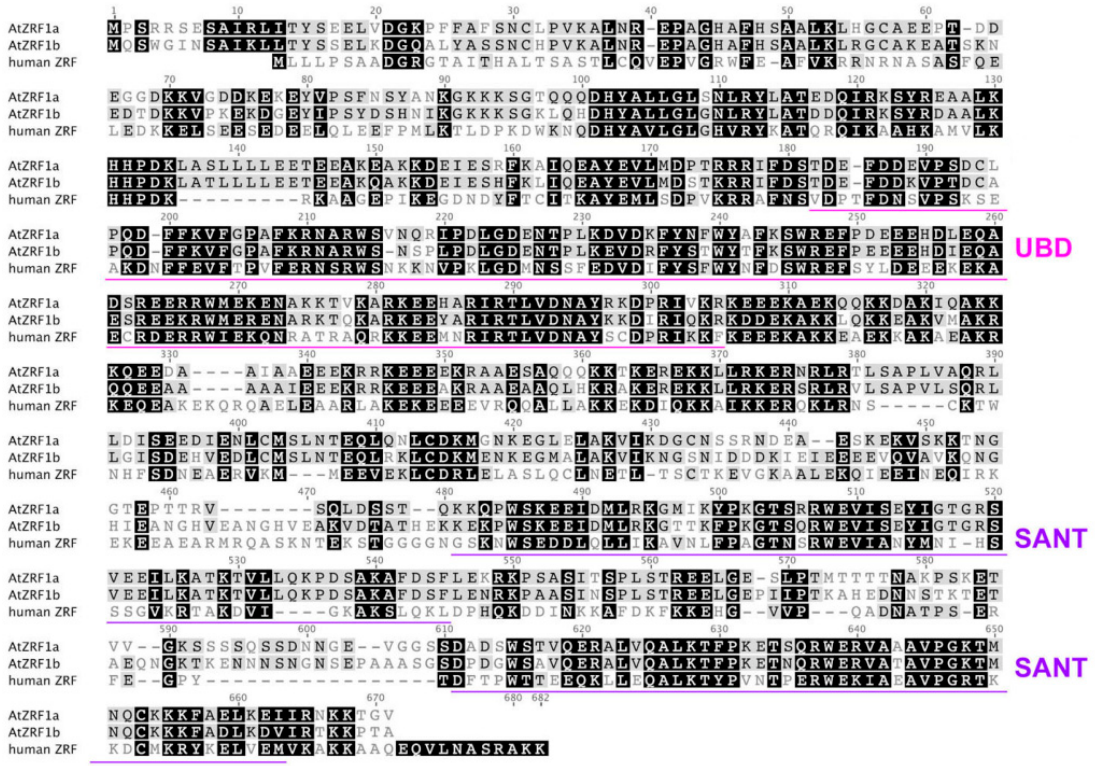
Figure 2. Sequence alignment of AtZRF1a and AtZRF1b together with the human ZRF1. The alignment was generated using the CLUSTALW program. The UBD and SANT domains are indicated[22].